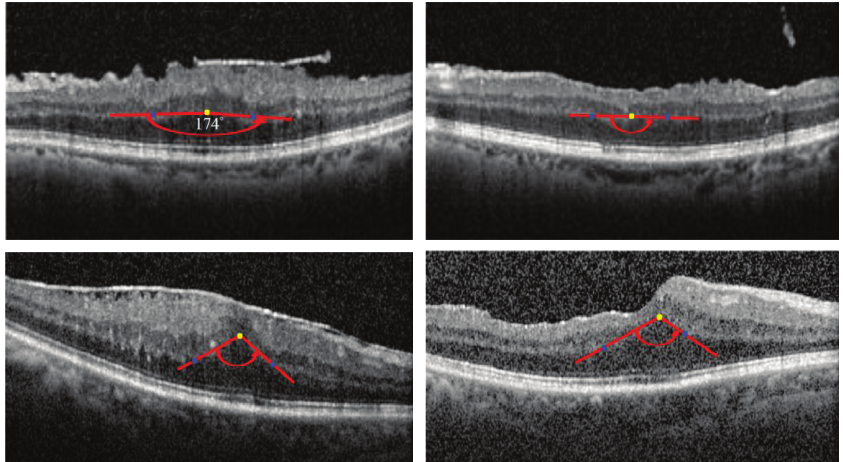
Figure 2: The OPL angle is measured from two lines (red) drawn from the OPL at the fovea (illustrated by yellow dots) to the furthermost intersecting point at either side of the OPL (illustrated by blue dots). (a) Patients’ retinas with greater prepeeling OPL angle ( ≥ 130 ° ). (b) Patients’ retinas that had smaller prepeeling OPL angle ( < 130 ° ). (c) Pre-ERM/ILM peeling OCT images (with the OPL angle of 174 ° as an example at the top left OCT image). (d) Post-ERM/ILM peeling OCT images. Abbreviations: OPL, outer plexiform layer; OCT, optical coherent tomography; ERM, epiretinal membrane; ILM, internal limiting membrane.